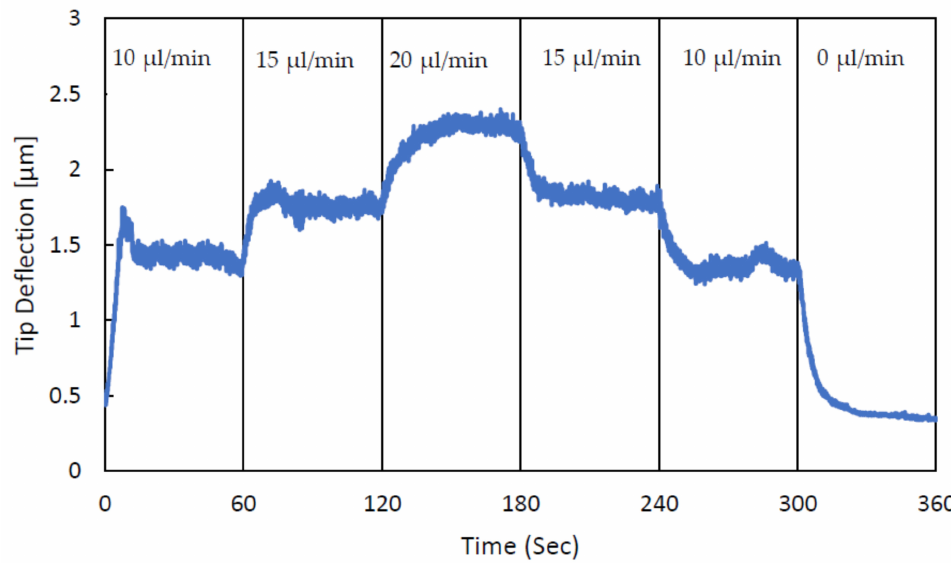
Figure 12. The sensitivity experiment of 3D suspended microcantilever has a 400 × 100 µ m 2 (width and depth) channel with various step flows of 10-15-20-15-10-0 µ L/min. The syringe pump flow rate changes every 60 s, and the SPMF 3 responds to this new flow rate.